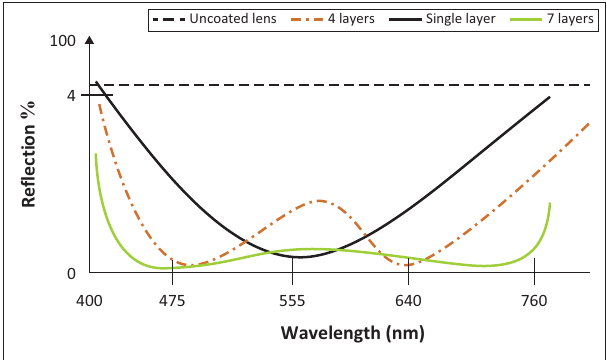
FIGURE 2: The reflectance as a function of incident wavelengths for uncoated and various multilayer antireflection coatings applied to CR39 lenses. 21